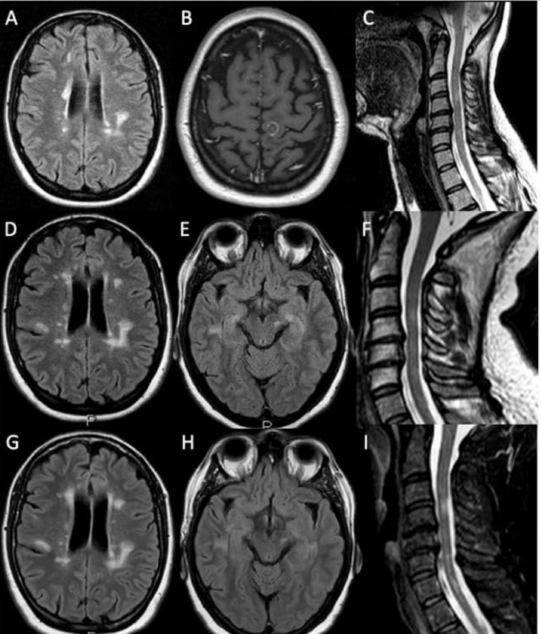
Figure 1. Patient’s brain and spinal cord MRIs. 1.5 tesla brain and spinal cord MRI obtained before and after IV gadolinium injection. November 2006: axial fluid-attenuated inversion recovery (FLAIR) and t2 weighted sequences showed the presence of multiple demyelinating lesions located in the periventricular and hemispheric deep white matter ( A ) and cervical spinal cord ( C ), including one contrast enhancing lesion in the left fronto-parietal juxtacortical white matter ( B ). November 2011: FLAIR and t2 weighted sequences showed the presence of multiple demyelinating lesions within the periventricular and hemispheric deep white matter ( D ), left mesencephalic ( E ) and cervical spinal cord regions ( F ). February 2018: brain MRI FLAIR sequences showed the presence of multiple demyelinating lesions located in the periventricular and hemispheric deep white matter ( G ) and left mesencephalic region ( H ) (superimposable on previous MRI studies) without new contrast enhancing lesions. Cervical spinal cord t2 weighted sequences displayed the presence of multiple demyelinating lesions (unchanged with respect to the previous MRI study) together with cervical spondylosis with posterior osteophytosis without spinal cord and nerve roots compression ( I